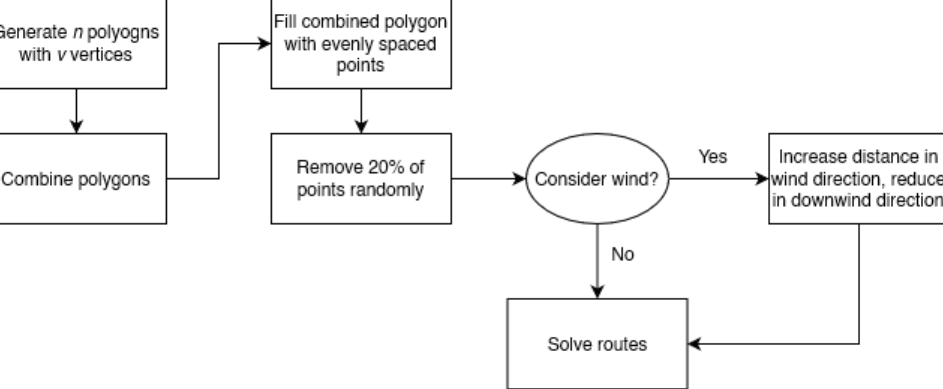
Figure 4. Flowchart describing the process of generating the simulated data with and without wind